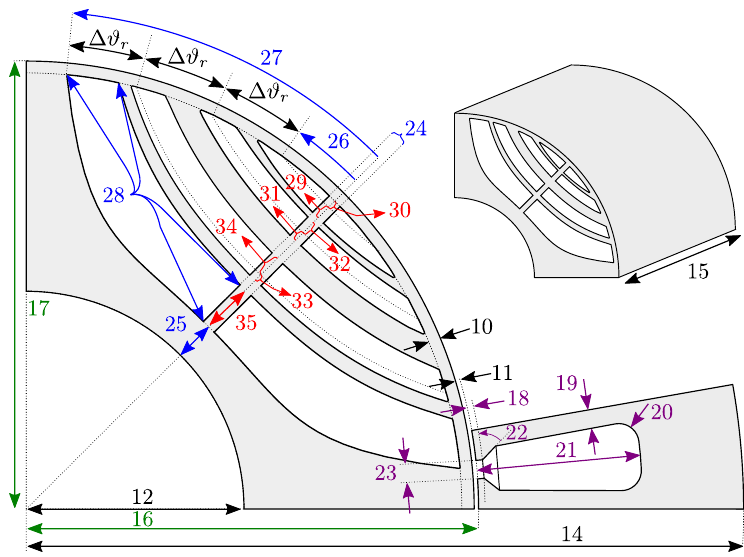
Figure 2. List of parametrization